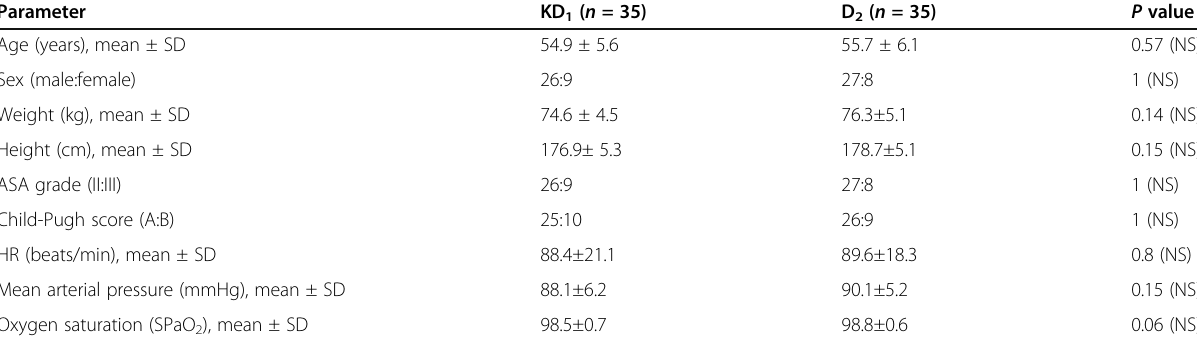
Table 1 Demographic data and baseline hemodynamic parameters in the two studied groups Parameter